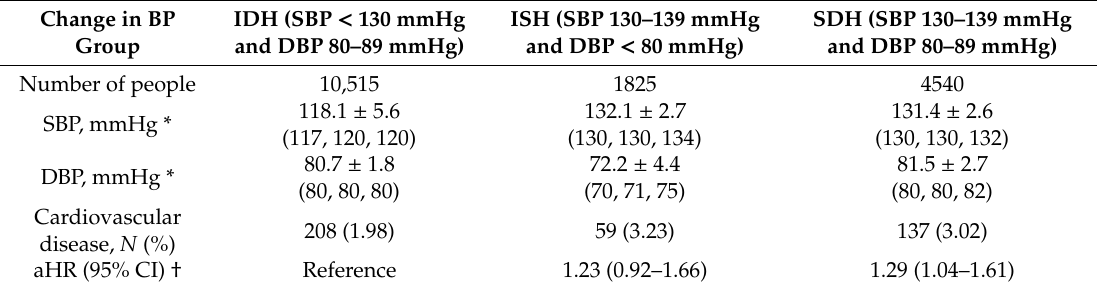
Figure 2. Kaplan–Meier curves demonstrating the incidence of cardiovascular disease (composite of nonfatal myocardial infarction, stroke, or cardiovascular death) according to the two-year blood pressure changes in people with previously normal blood pressure. Subjects had normal BP in first (2002 to 2003) periods and whose BP checked in second (2004–2005) periods was divided into four groups: normal (SBP < 120 mmHg and DBP < 80 mmHg), 2017 ACC/AHA defined Elevated BP (SBP 120–129 mmHg and DBP < 80 mmHg), Stage 1 hypertension (SBP 130–139 mmHg or DBP 80–89 mmHg) and Stage 2 hypertension (SBP ≥ 140 mmHg or DBP ≥ 90 mmHg). Table 4. Additional analysis of associations between three categorical changes in blood pressure and risk of cardiovascular disease in 2017 ACC / AHA defined Stage 1